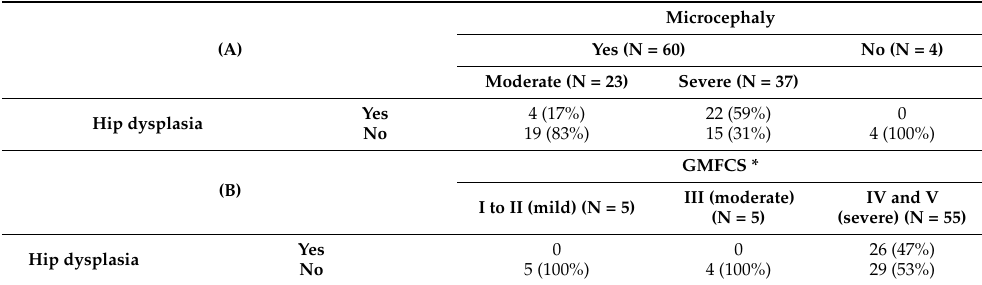
Table 2. ( A ) Frequency of hip dysplasia in children with and without microcephaly. ( B ) Frequency of hip dysplasia in children according to GMFCS